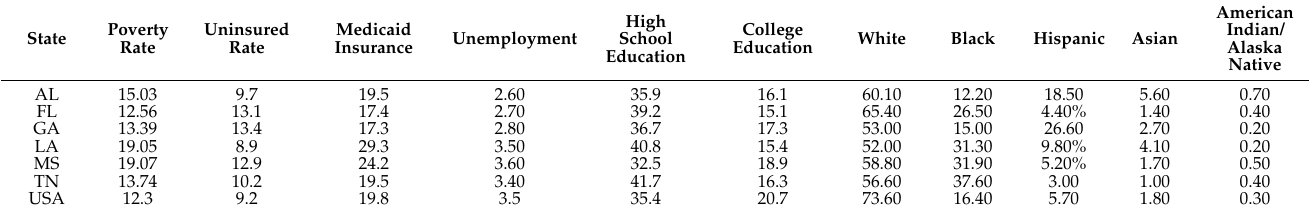
Figure 10. GIS Maps of COVID-19 cases and death rates in the selected states from March 2020 through February 2022. Table 4. Rates of socioeconomic status variables and the percent of racial